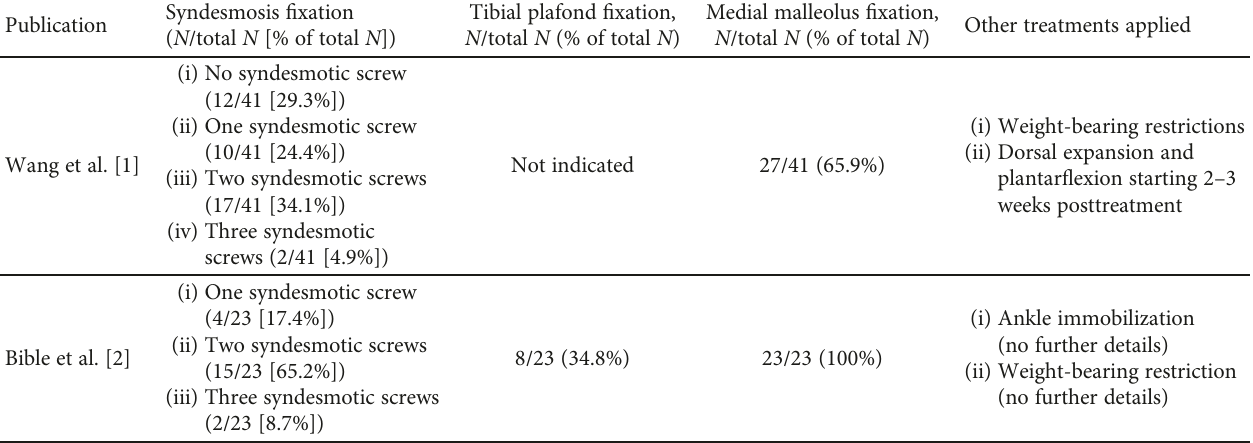
Table 2: Treatment applied to high-energy transsyndesmotic ankle fracture dislocation in published reports.